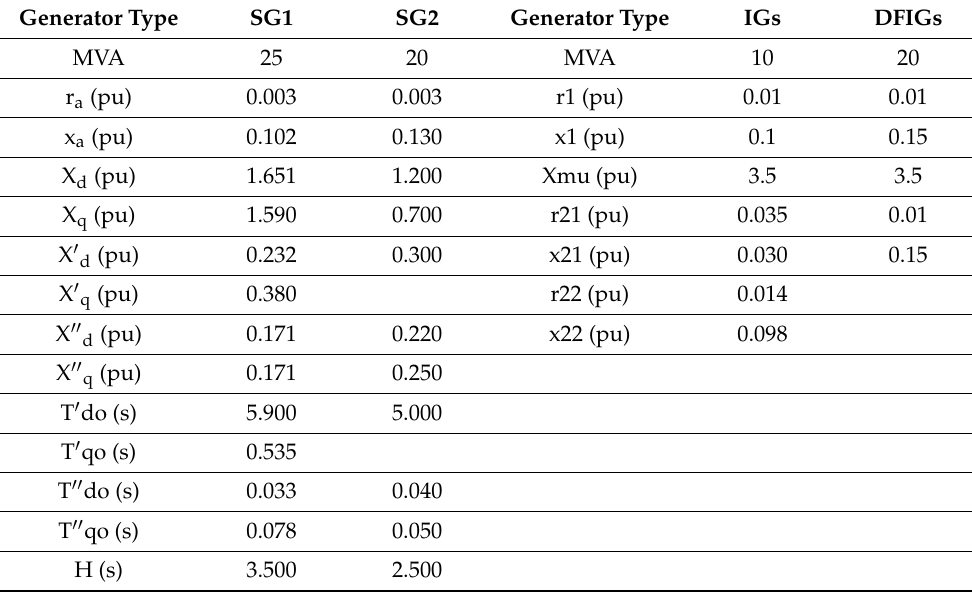
Table 1. Generator Parameters [39].